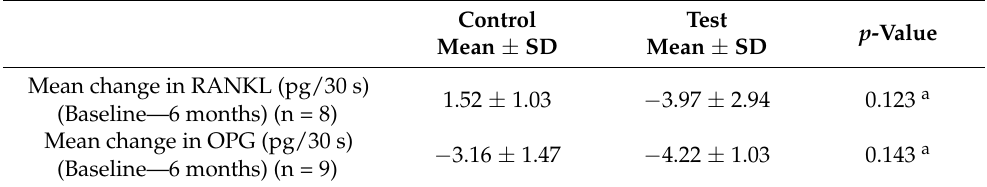
Table 5. Comparison of the changes in biomarker levels between the two groups.